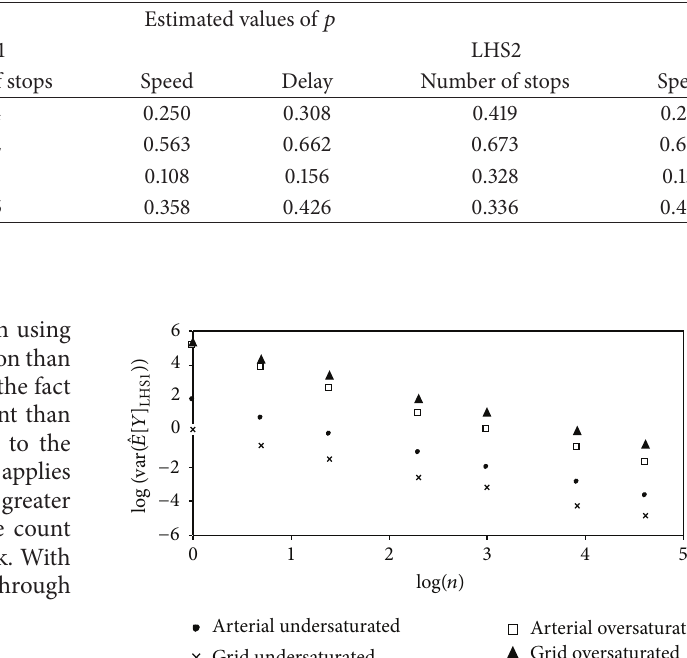
Table 3: Estimated values of 𝑝 under LHS1 and LHS2.